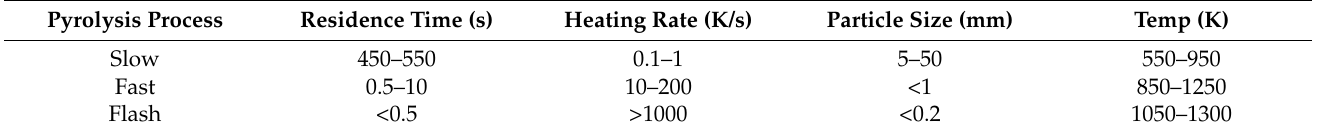
Table 1. Different kinds of pyrolysis processes and operating parameters